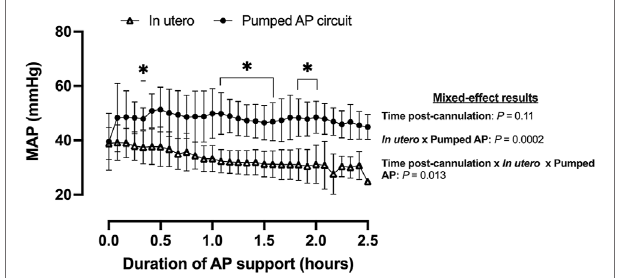
FIGURE 5 | MAP in fetal pigs studied in utero and maintained using a pumped AP circuit. Fetal pigs studied in utero are represented in open